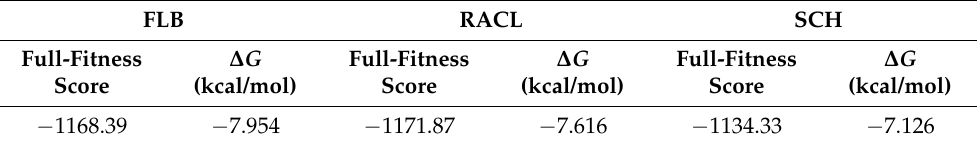
Table 1. Molecular docking results for D2DR-ligand top